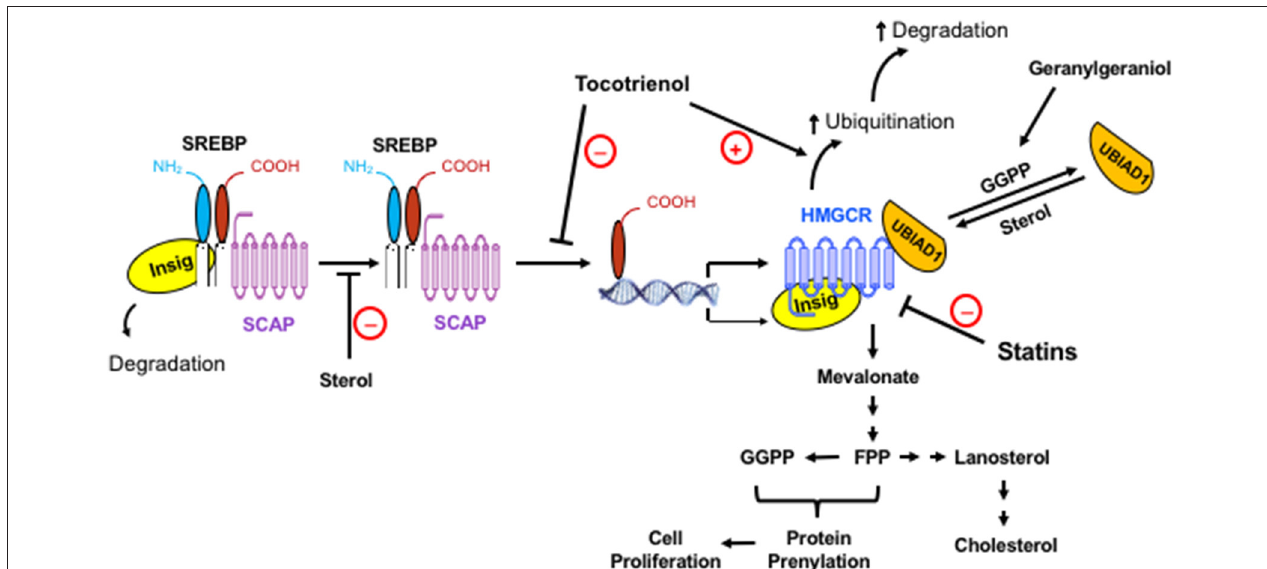
FIGURE 1 | The regulation of the mevalonate pathway and the role of mevalonate-derived metabolites in cell proliferation. When cellular level of sterol is low, Insig dissociates from the SREBP-SCAP complex, allowing the latter to move to the Golgi apparatus. Following proteolytic cleavage of SREBP, its basic helix-loop-helix fragment enters the nucleus, binds to the SRE domain of target genes, and initiates the transcription and synthesis of a number of enzymes in the mevalonate pathway, including its rate-limiting enzyme, HMGCR. The activated mevalonate pathway produces sterols and nonsterols, including FPP and GGPP for protein prenylation and cell proliferation. Sterols block the transport of the SREBP-SCAP complex to the Golgi apparatus and induce the binding of HMGCR to Insig, leading to the ubiquitination and degradation of HMGCR. Exogenous geranylgeraniol is phosphorylated and converted to GGPP, which induces the dissociation of UBIAD1 from HMGCR and facilitates the degradation of HMGCR. The statins competitively inhibit HMGCR. Consequently, the lack of sterols and nonsterols results in a compensatory upregulation of HMGCR. Tocotrienols and potentially other isoprenoids block the processing and nuclear localization of SREBP and enhance the ubiquitination and degradation of HMGCR. HMGCR is upregulated in tumors but remains sensitive to isoprenoid-mediated downregulation. Synergistic impact of isoprenoids and statins on tumor HMGCR may offer a novel approach in enhancing the efficacy of statins with reduced